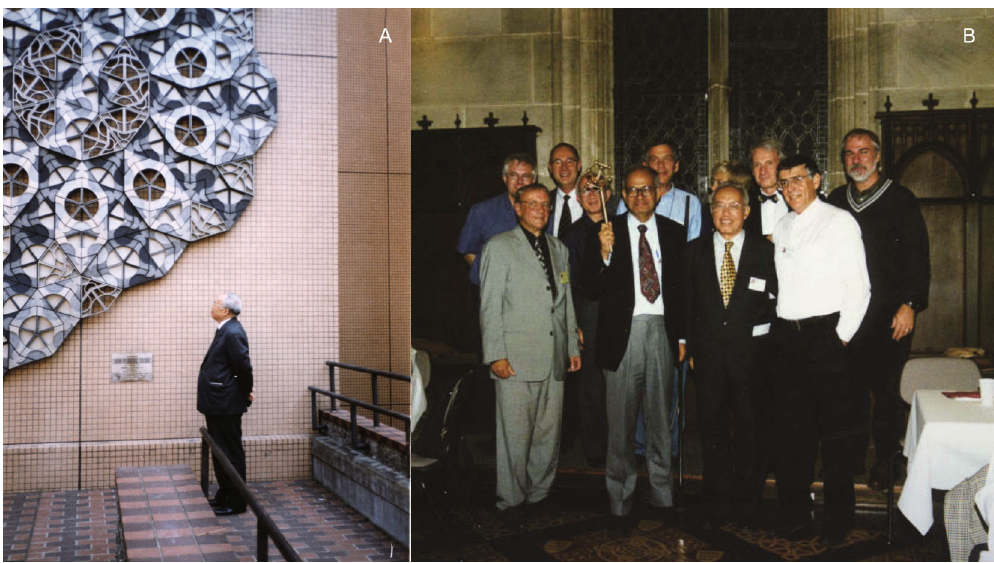
Figure 2. In front of a Penrose tiling at the Tokyo Metropolitan University (A). Attending the 7th International Conference on Quasicrystals, Stuttgart in 1999 (Front row, second from the right)